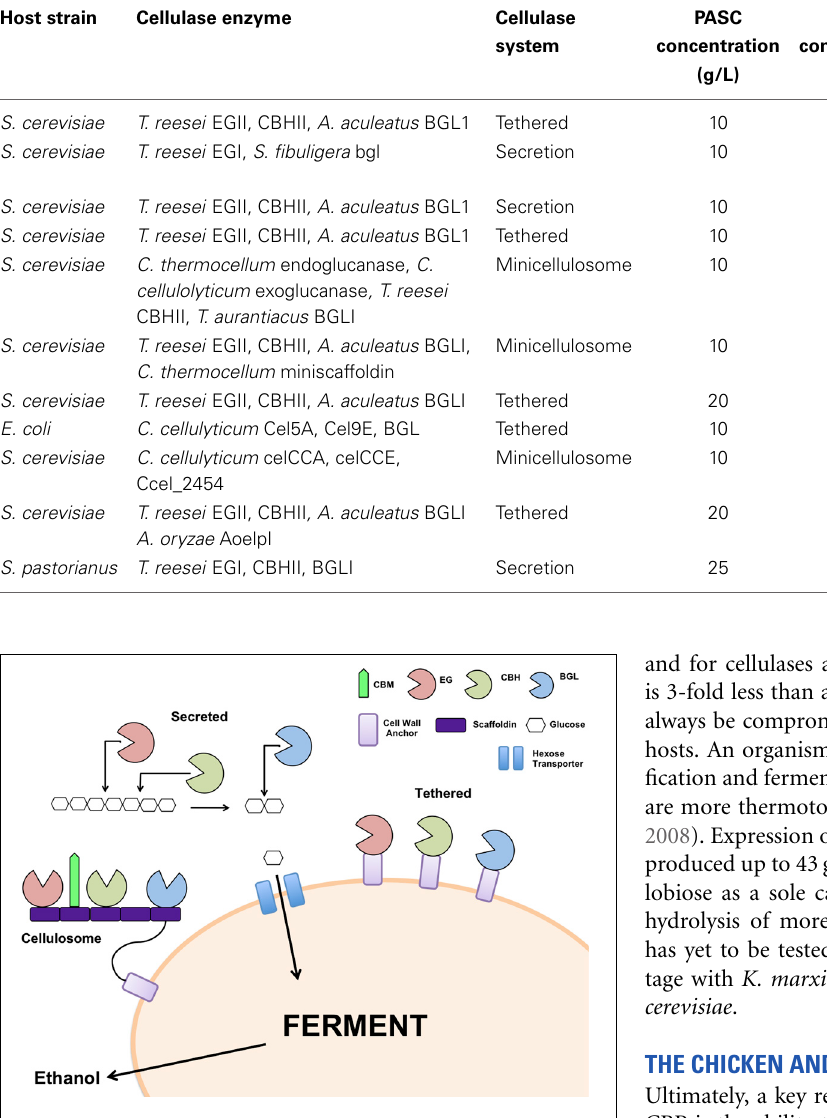
cellulose (PASC) degradation than the parental haploid